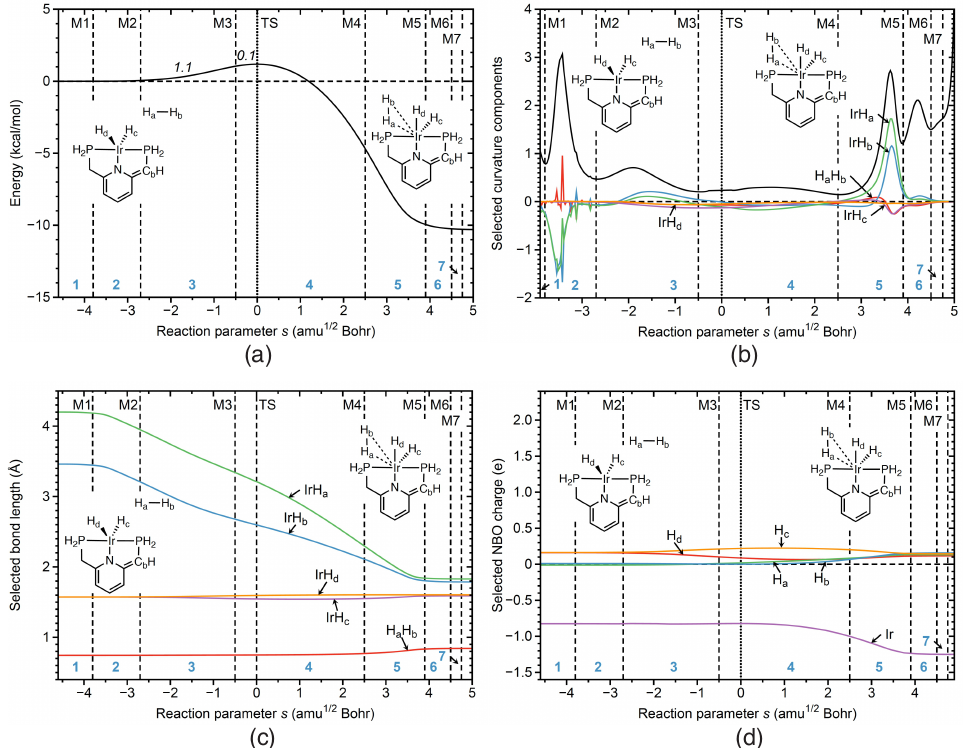
Figure 8. Properties of reaction R4 of the catalytic cycle along the reaction path. ( a ) Energy profile, energy contributions of each reaction phase to the activation energy are indicated by italic numbers; ( b ) decomposition of the reaction curvature into selected components; ( c ) change of selected bond lengths along s ; ( d ) change of selected NBO atomic charges along s . Positions of the curvature minima are shown as dashed vertical lines and are labeled as M1, M2, and so on. The position of the TS is indicated by a dotted line. Reaction phases are indicated by blue numbers. B3LYP/6- 31G(d,p)/SDD(Ir) level of